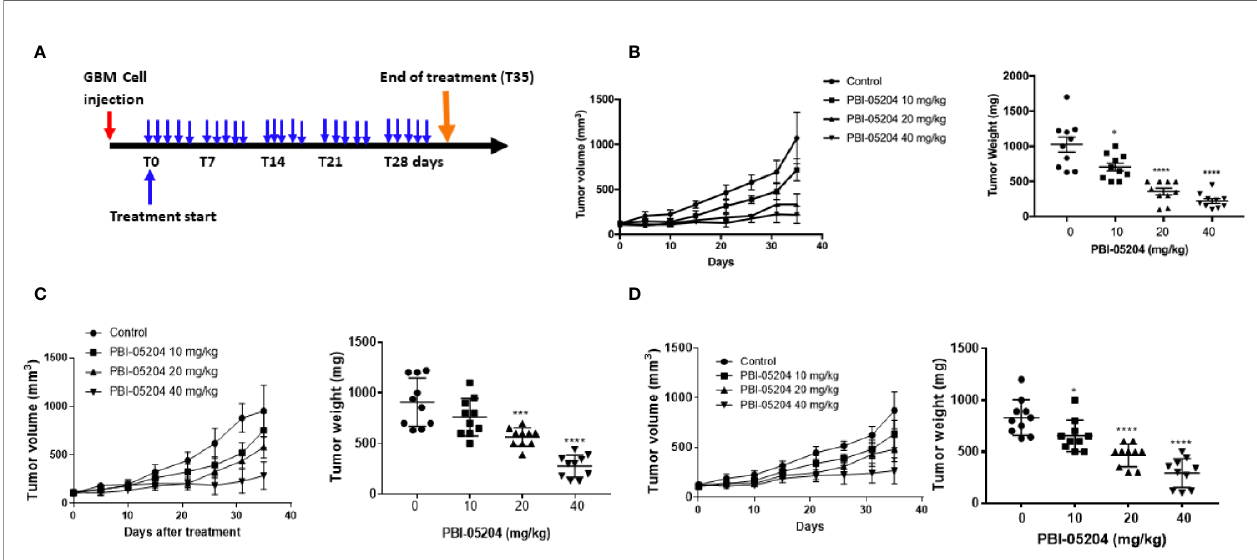
FIGURE 5 | PBI-05204 inhibited the growth of U87MG, U251, and T98G tumor in mouse xenograft model. (A) Schematic illustration of antitumor ef fi cacy study of PBI-05204 in mice bearing human GBM mouse xenograft tumors. (B) The tumor growth curve and weight of U87MG xenografts treated with PBI-05204. (C) The tumor growth curve and weight of U251 xenografts treated with PBI-05204. (D) The tumor growth curve and weight of T98G xenografts treated with PBI-05204. Data are presented as mean ± SD. *p < 0.05, ***p < 0.001, ****p < 0.0001 versus vehicle control.